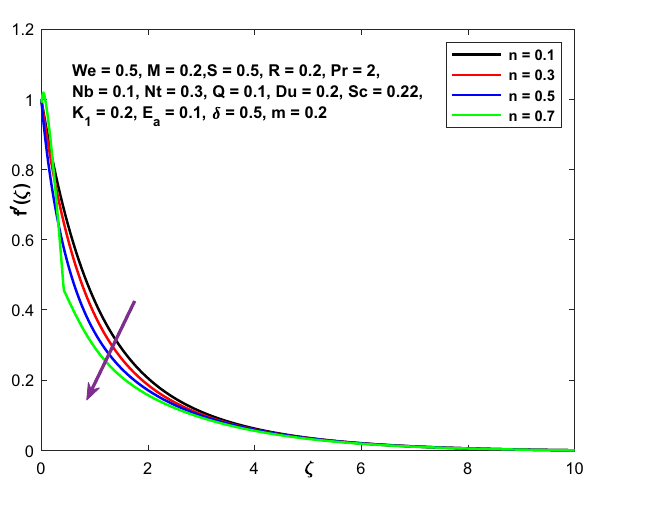
Figure 9. Character of n versus f ′ (ζ)